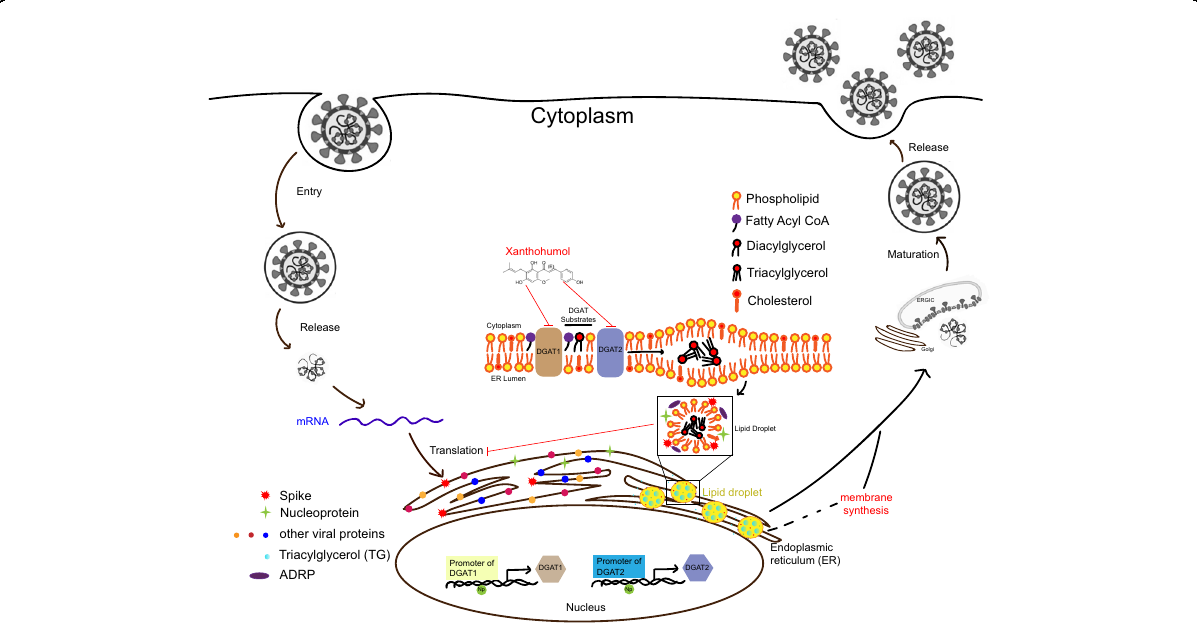
Fig. 6 Proposed model for host DGAT and ADRP in SARS-CoV-2 life cycle. Virus manipulates host glycerophospholipid metabolism through upregulation of TG synthesis and LD formation. Speci fi cally, viral NP trans-activates both DGAT1 and DGAT2 mRNA expression binding to their promoter regions, resulting in LD accumulation. Both DGATs and the other LD surface protein ADRP are required for SARS-CoV-2 replication. The identi fi ed compound Xanthohumol is a pan-DGAT1/2 inhibitor that exhibits anti-SARS-CoV-2 activity both in vitro and in